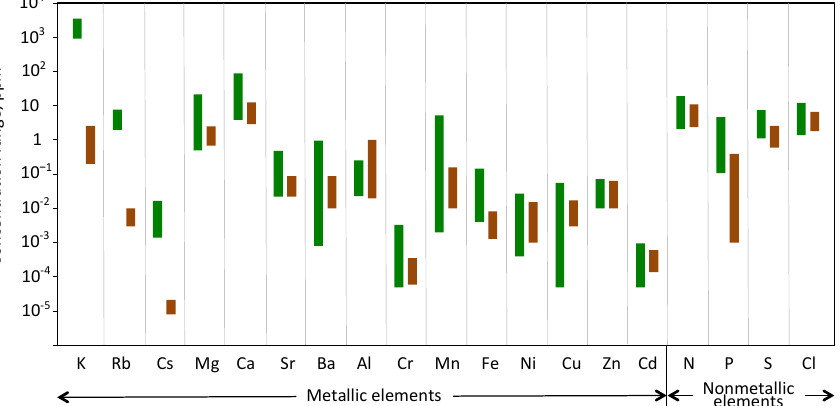
Figure 8. Concentration ranges of elements in the xylem sap and soil solution. Green bars: xylem sap, brown bars: soil solution.